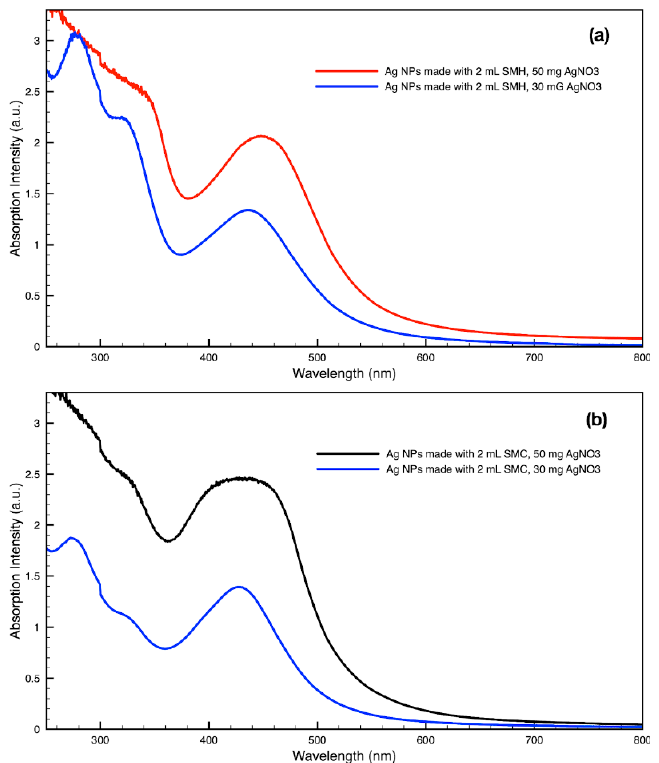
Figure 14. Absorption spectra of silver (Ag) nanoparticles (NPs) synthesized with either 30 mg or 50 mg of metal precursor, AgNO 3 , per 30 mL sample by ( a ) SMH and ( b ) SMC.